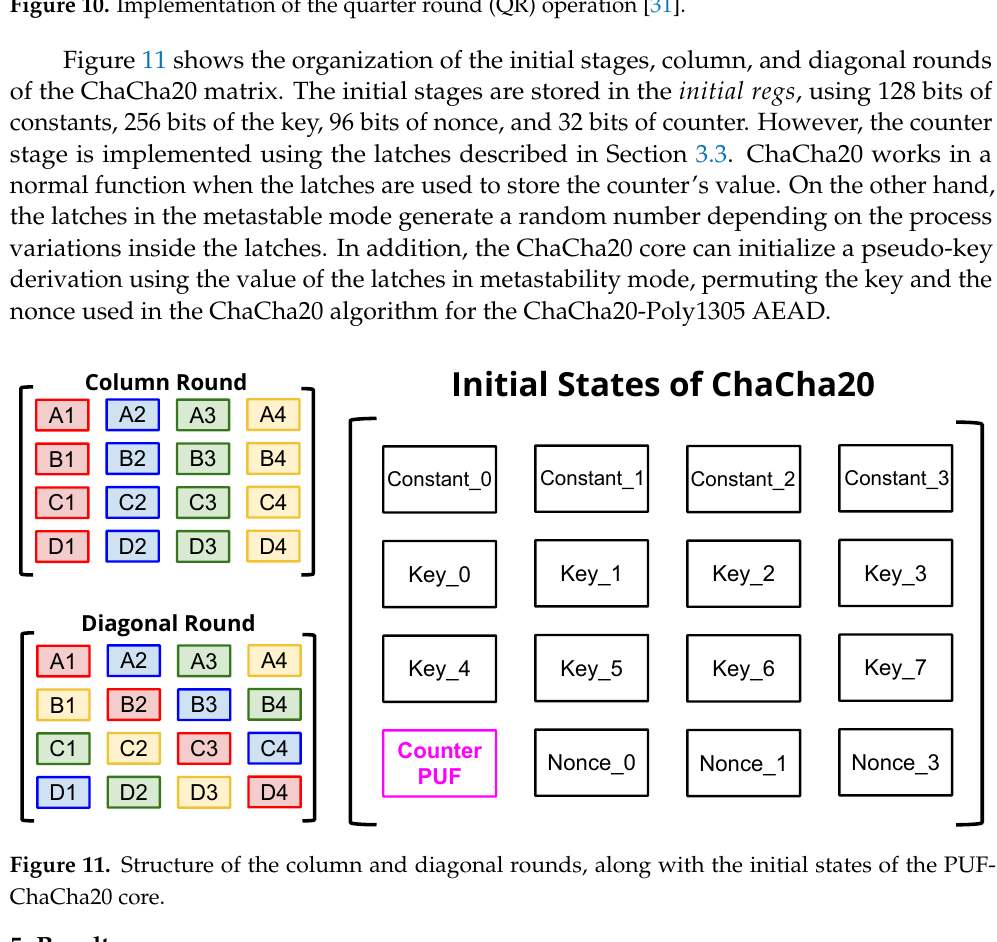
Figure 10. Implementation of the quarter round (QR) operation [31].